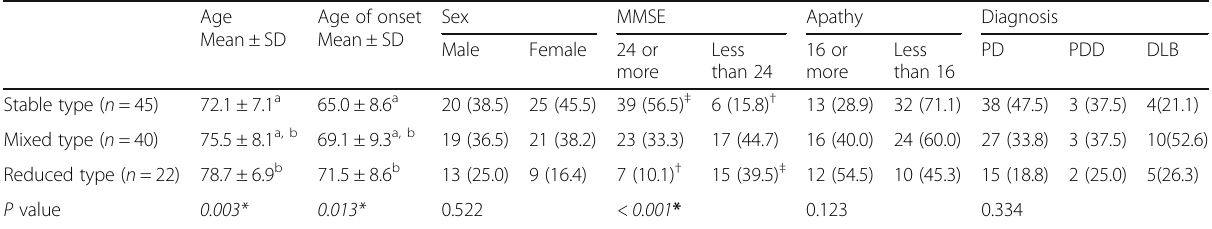
Table 5 Comparison of attributes by